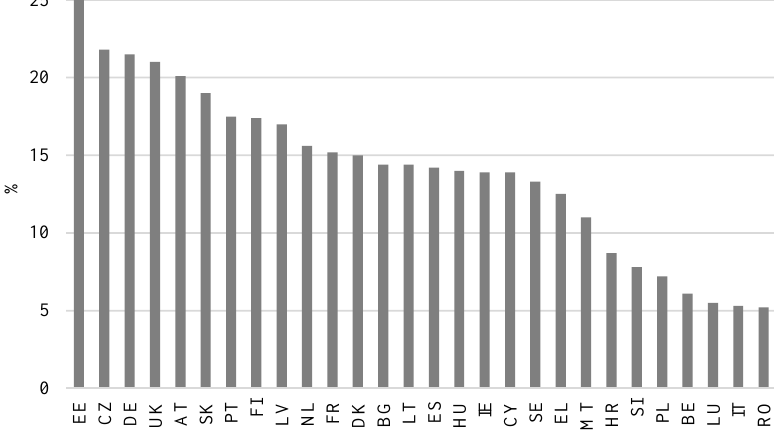
Figure 1. The unadjusted gender pay gap, 2016 (difference between average gross hourly earnings of male and female employees as % of male gross earnings)